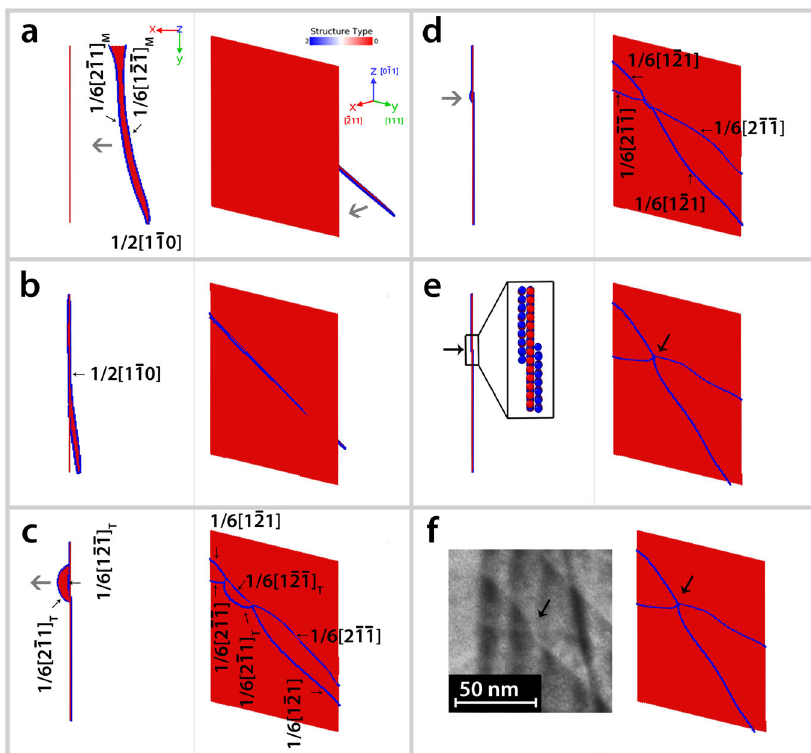
Fig. 4 large 3D-MD simulations of the formation mechanism of the constriction node in the CTB. Sequence of snapshots showing the formation of the constriction node in the CTB under uniaxial Z-tension (supplementary movie 4). The resolved shear stress acting on the screw component σ rss screw is equal to 204 ± 5 MPa and below the critical stress for transmission. a Dissociated screw dislocation propagating in the incoming grain. b Constriction into a perfect screw dislocation in contact with the CTB. c Competition between absorption in the 111 ð Þ CTB plane and transmission on the 111 twinned grain. d and e Reabsorption of the cross-slip nucleus in the twinned grain resulting in the formation of a construction node. The magni fi ed image in the black rectangle in e shows that the constriction node is a TB step of three atomic planes with edges located on both sides of the CTB. f Comparison between the simulated node in e and the experimentally observed node indicated by black arrow in Fig. 3c. The atoms are coloured according to the CNA analysis, only the non-FCC atoms are